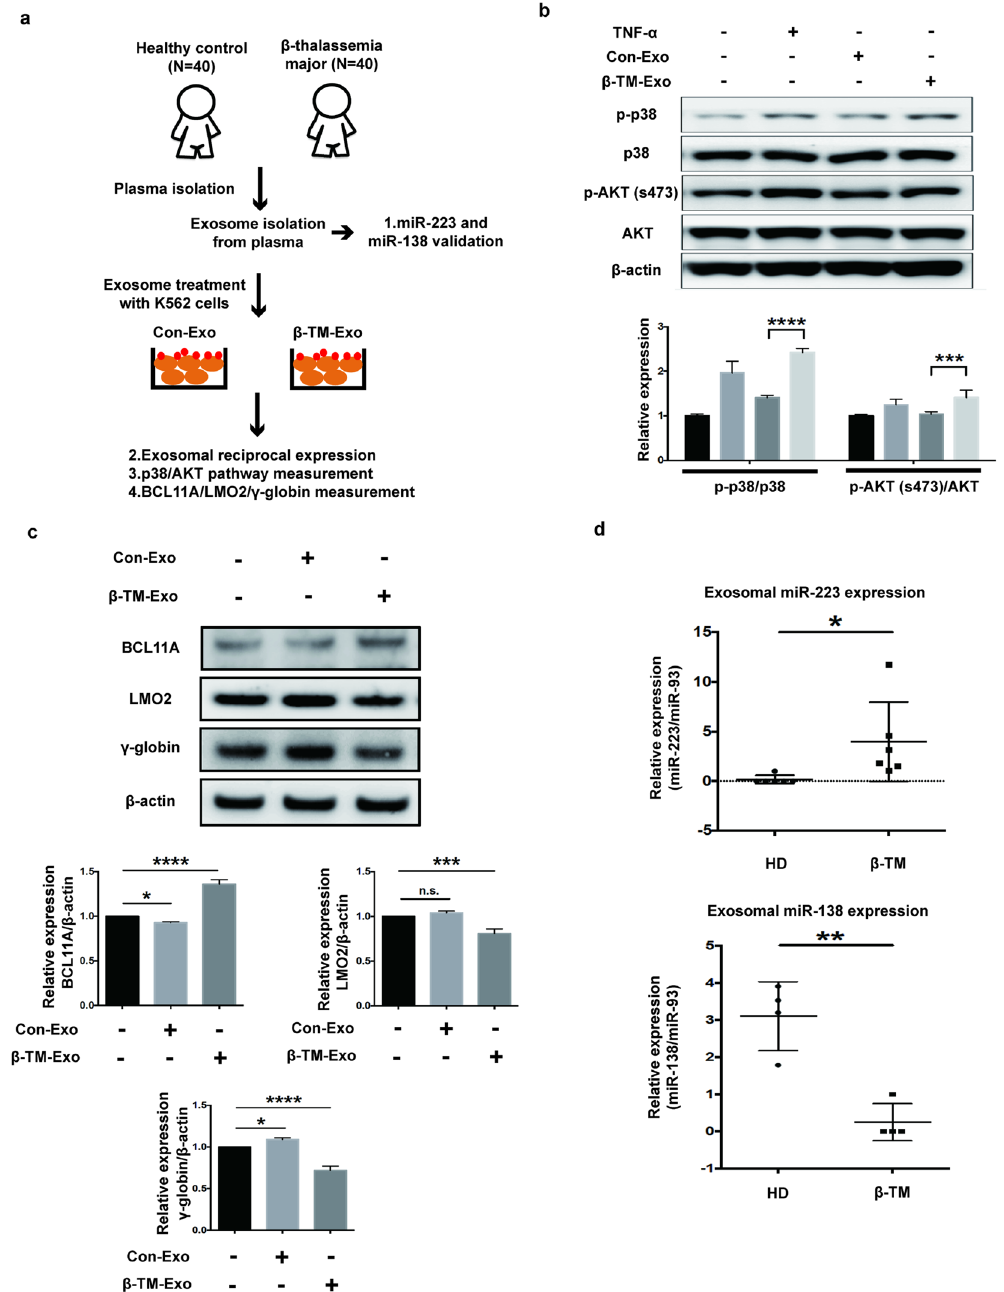
Figure 5. Exosomes reciprocally regulate γ -globin expressions. ( a ) Schematic representation of exosome isolation, exo-miRNA validation and γ -globin regulation. ( b ) Immunoblot analysis of p-AKT, p-p38 levels in K562 cells treated with β -TM or HD plasma exosomes. Experiments were performed in triplicates. The values represented are mean ± SD, one-way ANOVA, *** P < 0.001, **** P < 0.0001, Prism6 (GraphPad Software Inc.). ( c ) Western blot of LMO2, BCL11A and γ -globin expressions in K562 cells treated with HD and β -TM exosomes. The values represented are mean ± SD, one-way ANOVA, * P < 0.05, *** P < 0.001, **** P < 0.0001, Prism6 (GraphPad Software Inc.). ( d ) RT-qPCR analysis for plasma exo-miR-223-3p and plasma miR-138-5p expressions in HD (n = 15) and β -TM (n = 20). Data are presented as scatter plots, and the line represents the mean. Experiments were performed in triplicates. The values represented are mean ± SD, two-way ANOVA, * P < 0.05, ** P < 0.01, Prism6 (GraphPad Software